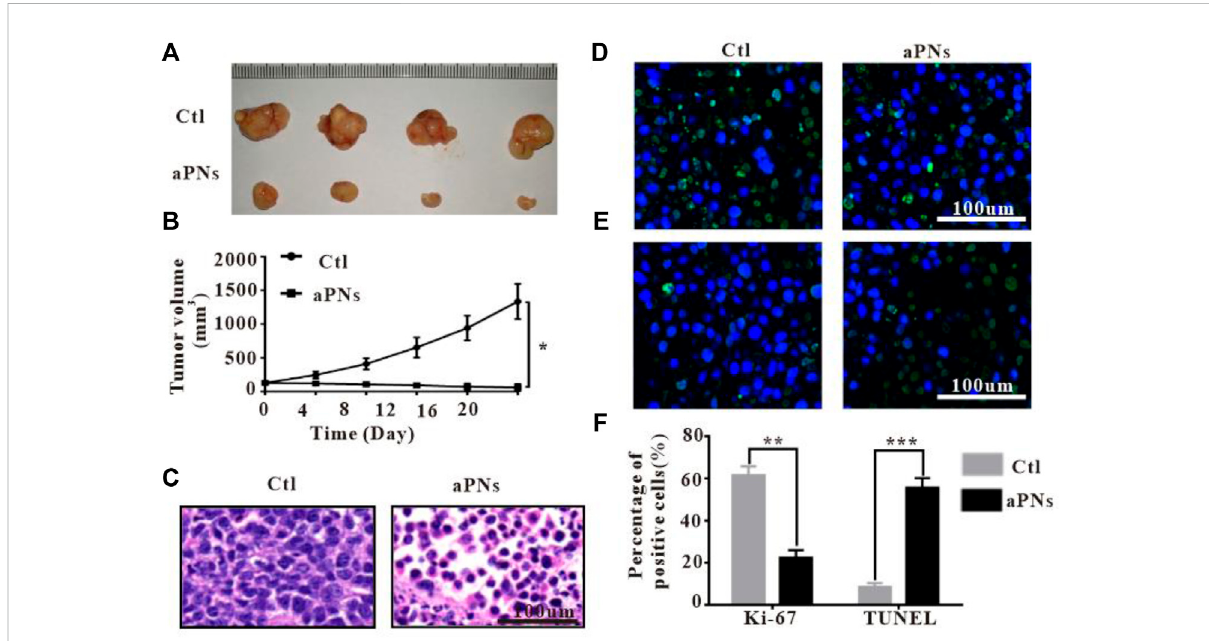
FIGURE 3 In vivo antitumor activity. Ctl: control; aPNs: activated PLTm nanovesicles. (A) Representative imageof tumor tissues. (B) The changesof tumor volume. Data are represented as mean ± SD ( n = 3), compared with control: p p < 0.05. (C) Histological images of tumor sections, scale bar: 100 μ m. (D) Histological images of tumor sections after Ki-67 immuno fl uorescence staining, scale bar: 100 μ m. (E) Images of tumor tissue after